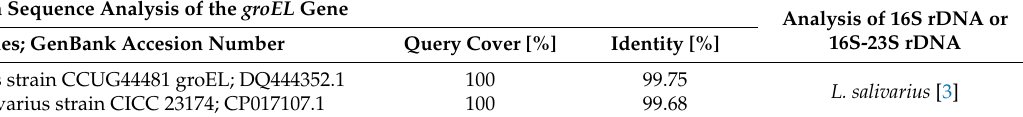
Table A2. Carbohydrate fermentation profiles of L. salivarius strains: ARA—arabinosel; RIB—ribose; XYL—xylose; GAL—galactose; GLU—glucose; FRU—fructose; MNE—mannose; RHA—rhamnose; MAN—mannitol; SOR—sorbitol; NAG-N—acethylglucosamine; AMY—amygdalin; SAL—salicin; CEL—cellobiose; MAL—maltose; LAC—lactose; MEL—melibiose; SAC—sacharose; TRE—trehalose; INU—inulin; MLZ—Melezitose; RAF—raffinose; XLT—xylitol; FUC—fucose. Symbols indicate the following: − , negative reaction; ± , weak rection; +, positive reaction after 24, 48 and 72 h, respectively. 6-Deoxy Pentoses Hexoses Hexoses Carbohydrate (cid:73) ARA